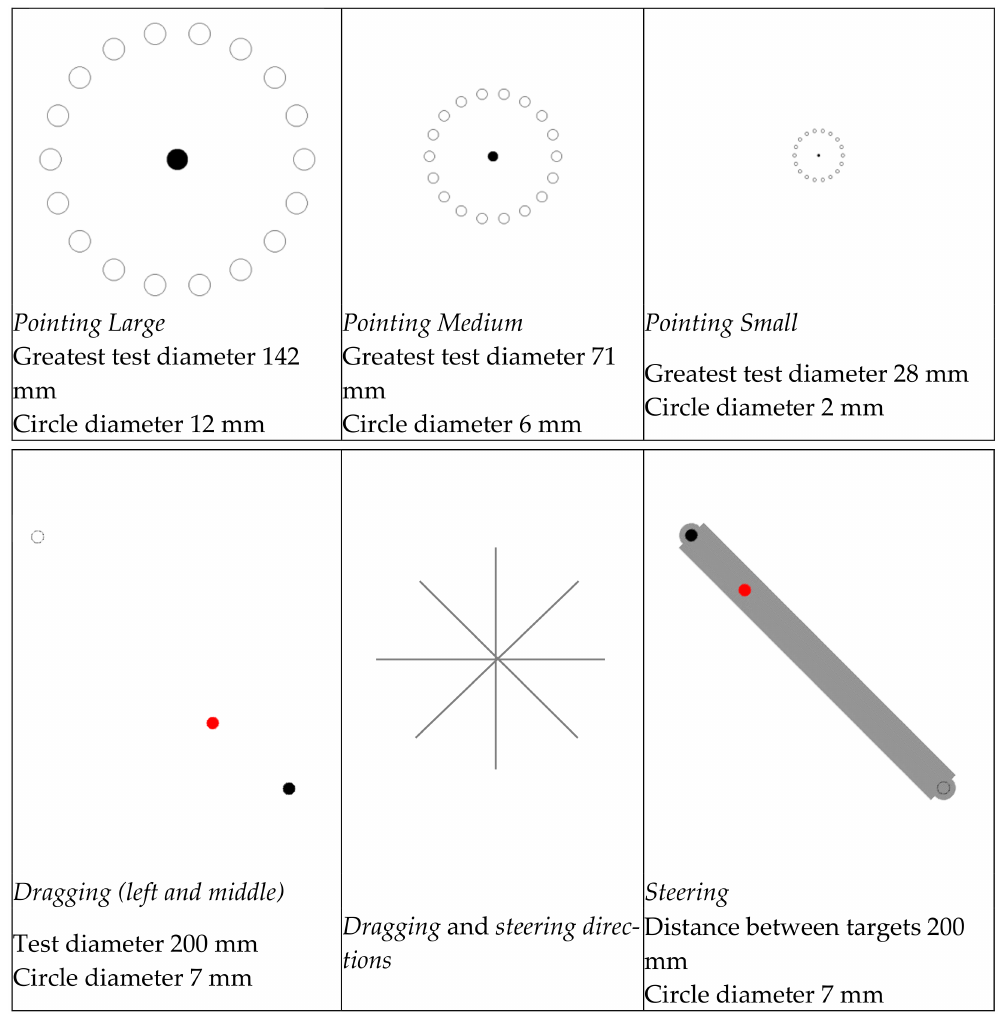
Figure 1. Test tasks (pointing, dragging, and